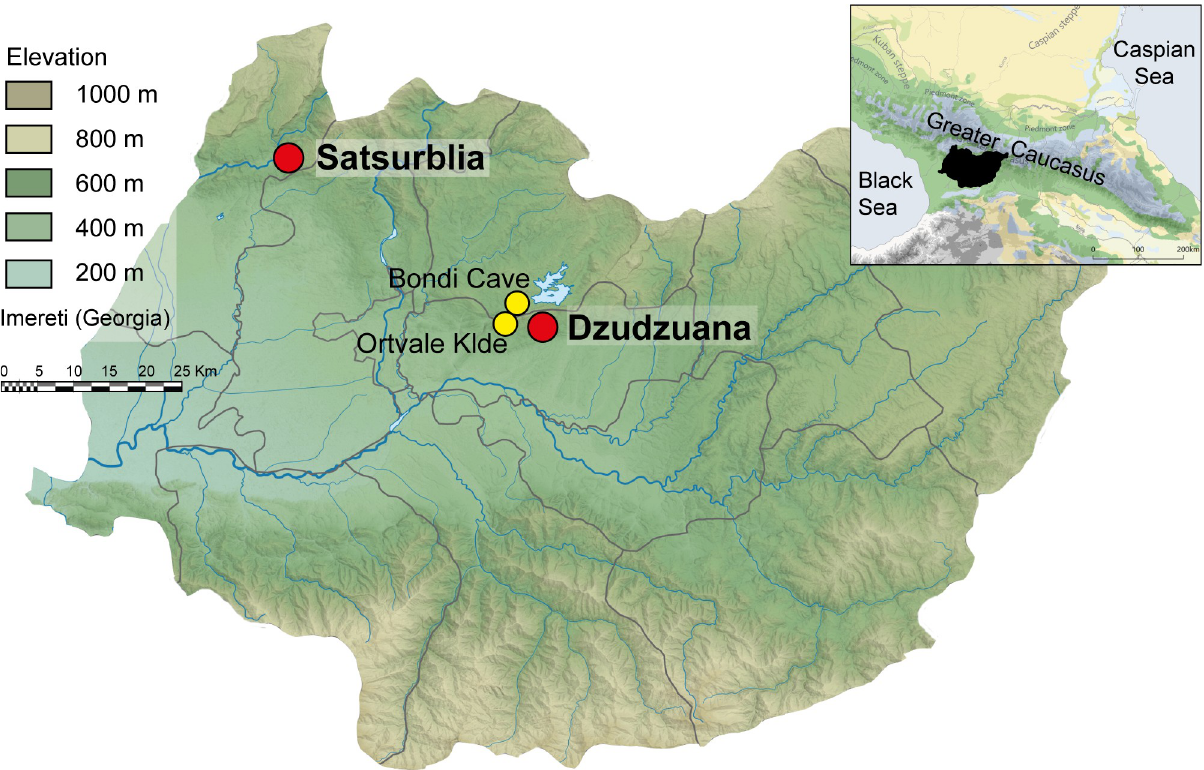
Fig 1. Location of Dzudzuana, Satsurblia and other Imeretian sites mentioned in the text. Main map provided by Wikimedia Commons under a Creative Commons Attribution-Share Alike 4.0 International (author Giorgi Balakhadze), original copyright 2018. Background map after Stone, T.A., and P. Schlesinger. 2003. RLC Vegetative Cover of the Former Soviet Union, 1990. ORNL DAAC, Oak Ridge, Tennessee, USA. This dataset is openly shared, without restriction, in accordance with the NASA Data and Information Policy.